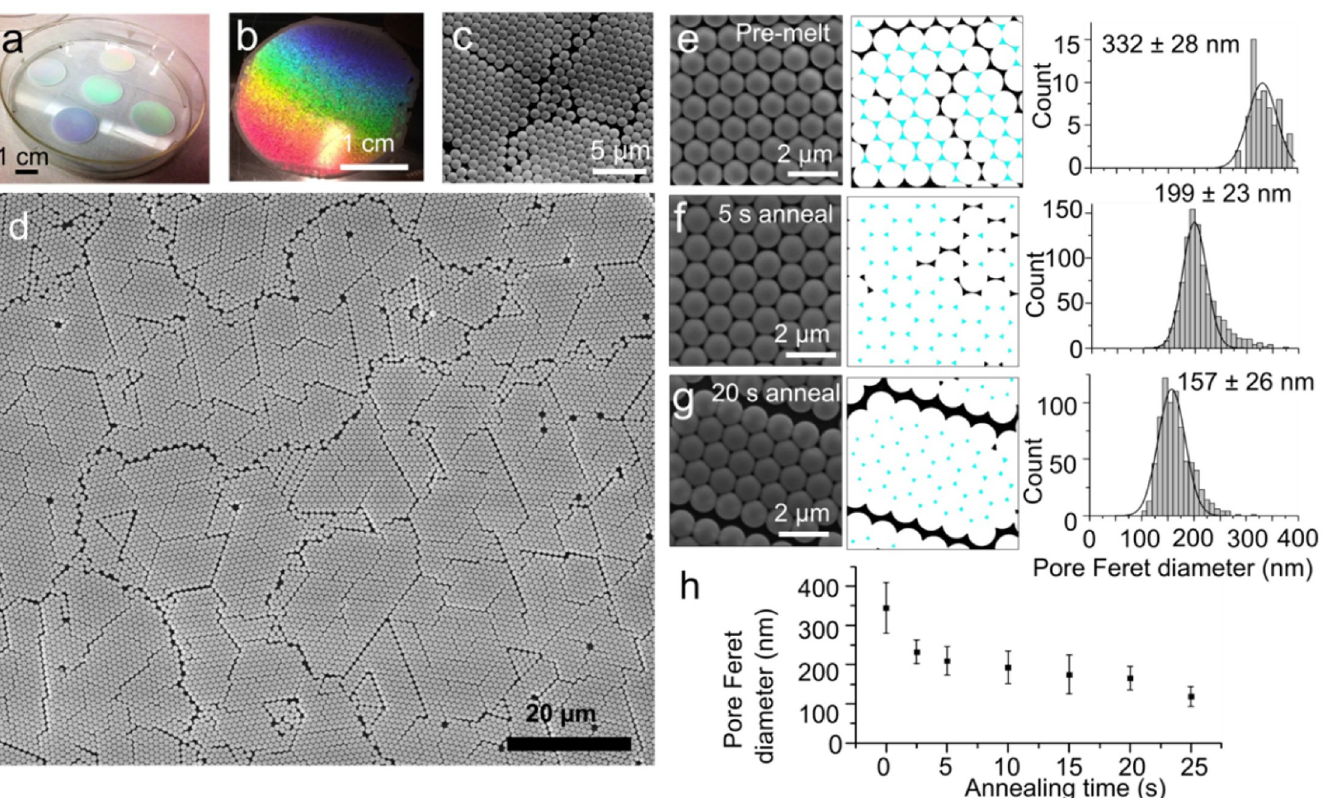
Fig 2. Annealing of 2D crystalline arrays of polystyrene beads. Macroscopic images of 2D crystalline arrays of polystyrene beads displaying rainbow structural coloration (a,b) and SEM images of the hexagonal arrays (c,d). SEM images of beads that were not heated (e), or were heated at 107˚C for 5 s (f) or 20 s (g), with corresponding interstitial areas selected (cyan) and maxFeret diameter histograms for the measured areas. (h) Interstitial maxFeret diameter from SEM images as a function of melting time. Error bars represent standard deviations.